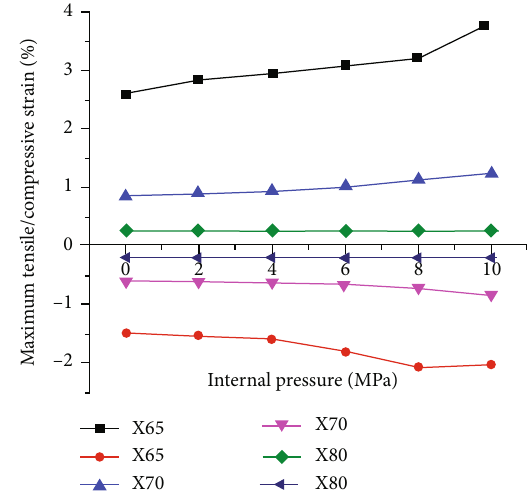
Figure 13: Relationship between maximum tensile and compressive strains and pipe internal